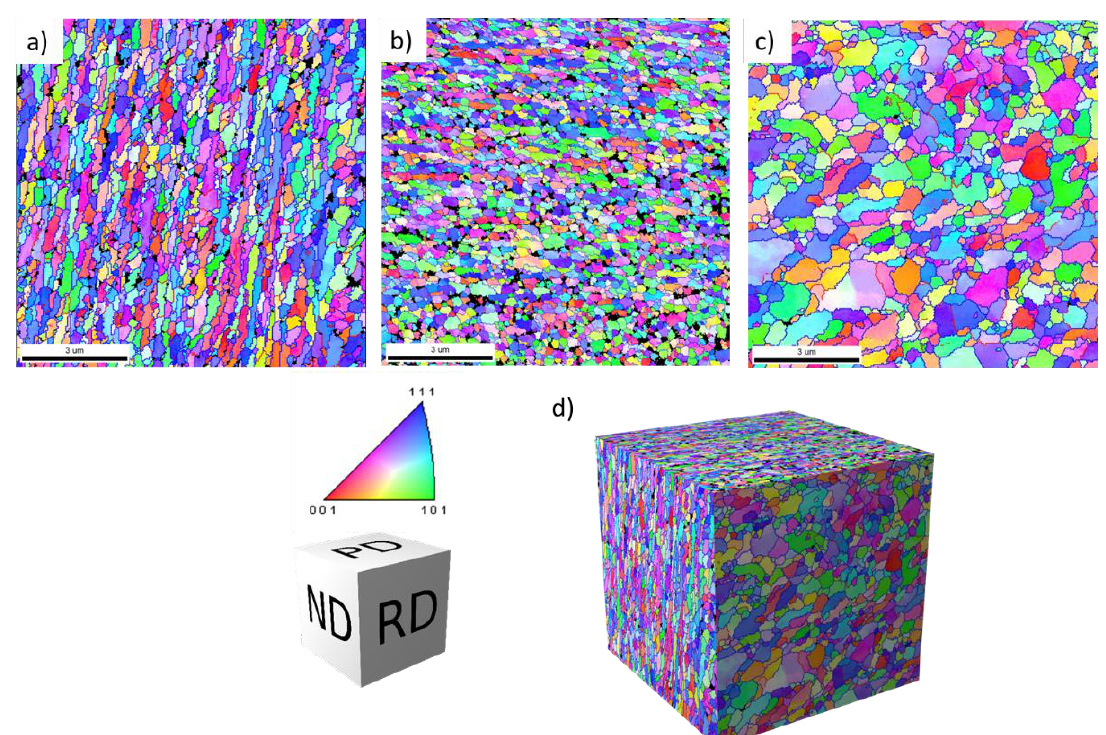
Figure 5. The microstructure of the completely CSET processed tube in the middle of the tube wall (position J in Figure 2) on three perpendicular planes. OIMs taken on plane ND ( a ), on plane PD ( b ), and on plane RD ( c ), along with the 3D reconstruction of microstructure ( d ). The IPF triangle represents the colours of the orientations in ( a – c ) and the schematic cube shows the orientation of the cube in ( d )